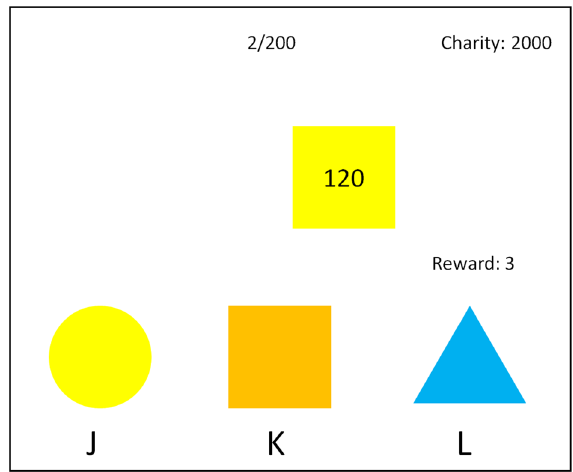
Figure 1. An illustration of a computer screen seen by a participant. The top row shows information about the number of the current trial, the total number of trials, and the number of points currently assigned to the charity organization. In the middle of the screen, an object (a yellow square in this case) is moving from the left side of the screen to the right. The current participant’s reward in points is shown to the right of the screen. In the bottom row, a participant sees which shapes and colors are assigned to keys “J,” “K,” and “L” in this trial (in this example, J is a yellow circle, K is an orange square, and L is a blue triangle). If the participant presses “J,” the object would be sorted by its color, that is correctly, and the participant would gain 3 points. If the participant presses “K,” the object would be matched to a wrong color, and would cause a loss of 200 points for the